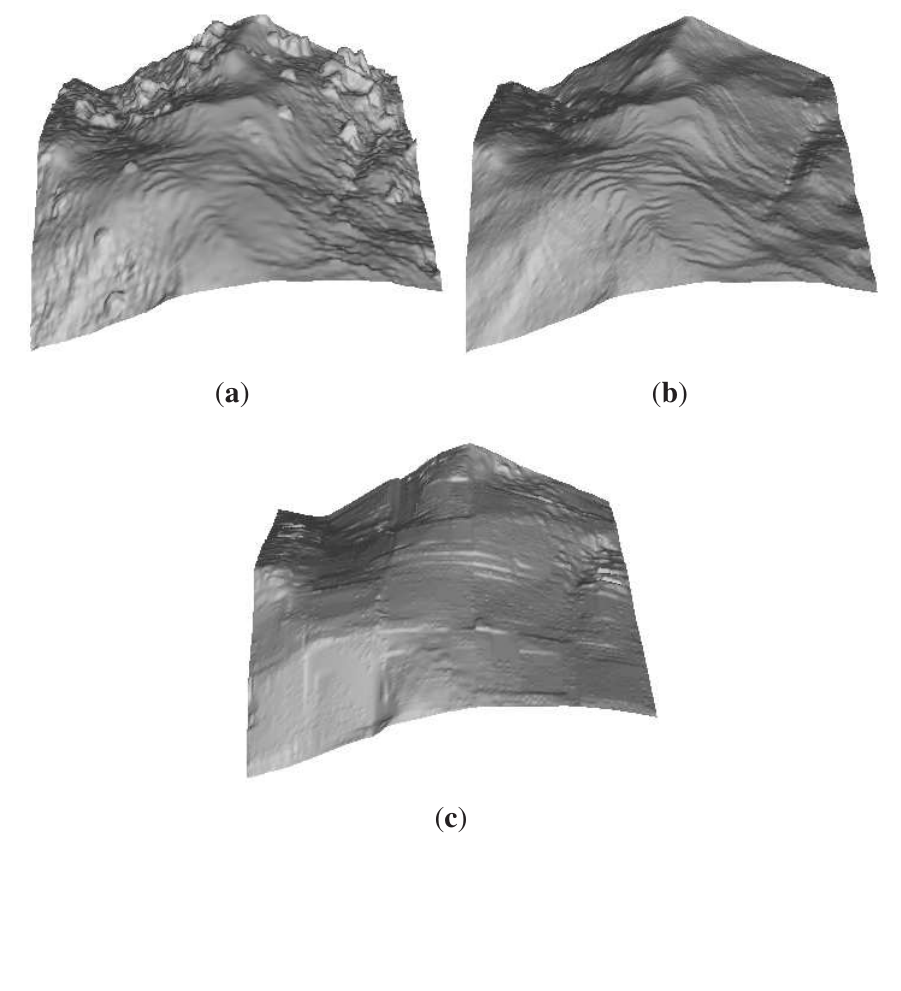
Figure 10. Comparing DTMs produced by (a) Karl Kraus (KK), (b) Peter Axelsson (PA) and (c) Maguya Almasi (MA) at Site 1. The width of the DTM section is approximately 400 m. (d) Difference model: KK − MA ; (e) Difference model: P A − MA